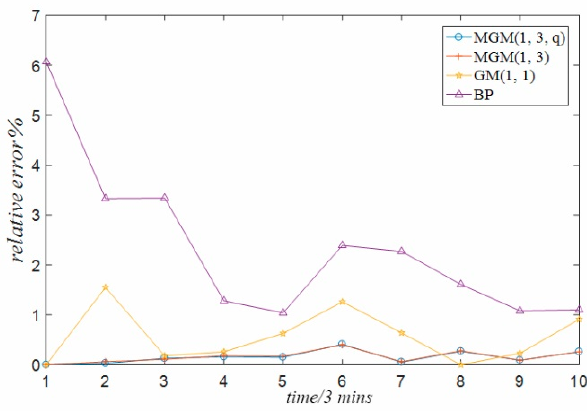
Figure 9. Relative error of thrust bearing.